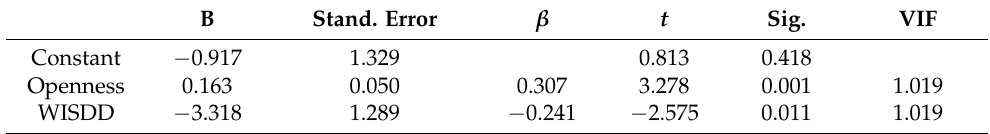
Table 2. Regression model with positive attitude towards foreigners as dependent variable. B Stand. Error